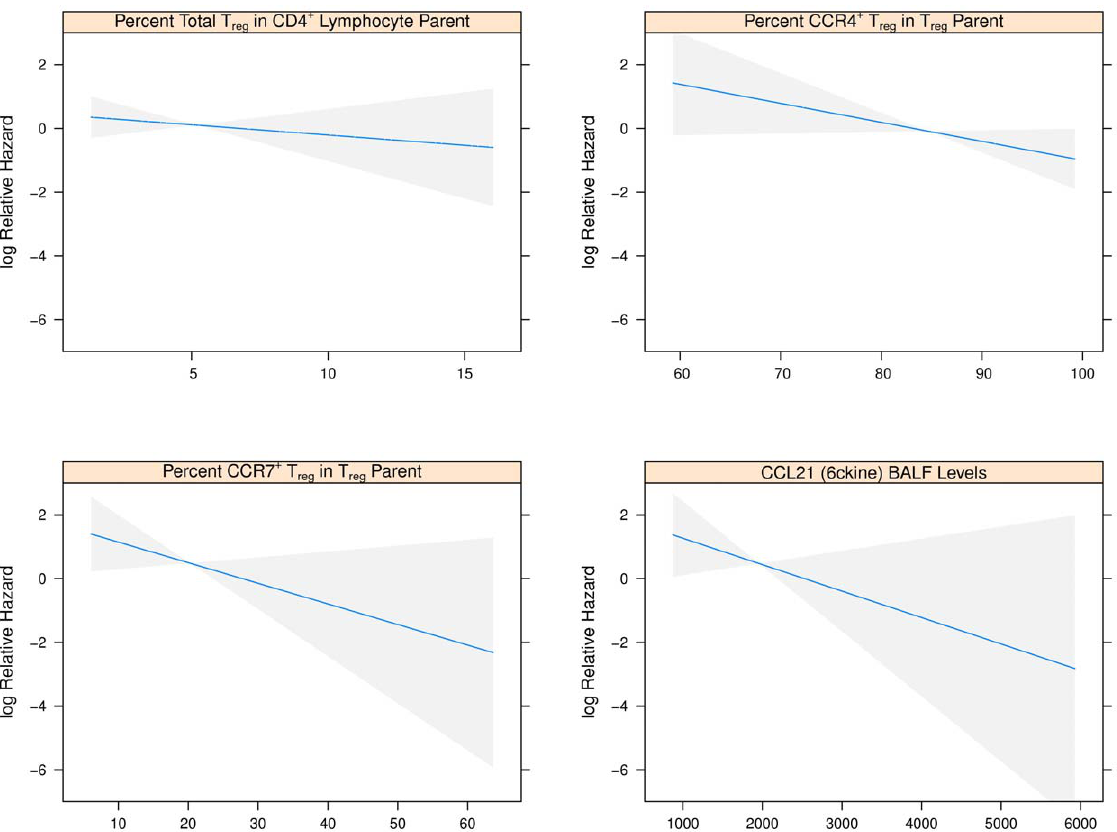
Figure 4. Plots of the log Cox Relative Hazard ratio for BOS against percent T regulatory lymphocyte subsets. The log of the Cox Relative Hazard (y-axis) decreases, i.e., less likely to develop BOS, as the percent of Treg, Treg subset or CCL21 protein level (x-axis) increases. The steeper the curve, as indicated by the blue line, the more protective the association with each Treg subset. The most significant effect is seen with the CCR7 + Treg subset. Confidence intervals are given by the gray bands. (top left) A plot for total BALF Treg, which demonstrates a non-significant protective effect. (top right) A plot of percent CCR4 + Treg, which demonstrates no significant protective effect. (bottom left) A plot of percent CCR7 + Treg, which demonstrates a significant protective effect. (botom right) A plot of BALF CCL21 protein level (pg) as determined by ELISA, which demonstrates a significant protective effect.